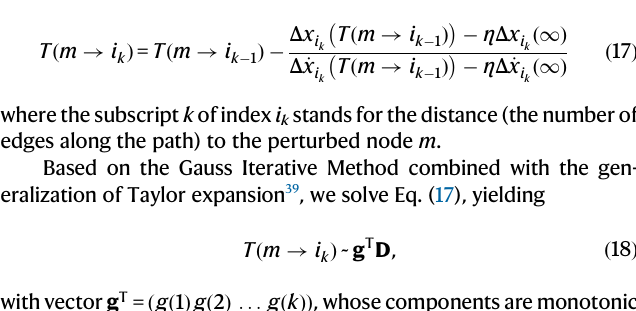
Fig.3|Impactofdegreesequencesonglobalpropagation.a , b Propagationtime as a function of average degree and degree variance for a chain of 8 nodes with random degree sequence and the fi rst node set as a perturbation source. Propa- gationtimeisaveragedacrossdifferentrealizations.c,dAveragepropagationtime versusmeandegree,forsequencesof fi xedvariance3and5,respectively.Response time and mean degree in ( c ) show positive correlation, while ( d ) shows a negative correlation. Response time versus max ð d θ J i Þ for θ J =0.25>0 ( e ) and min ð d θ J i Þ for